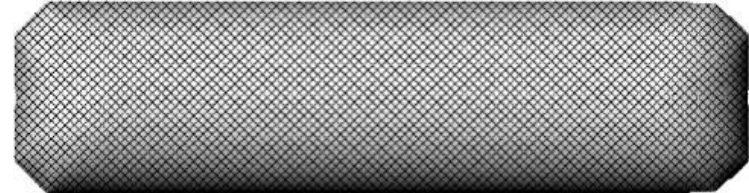
Figure 2. Schematic diagram of cable net layout.